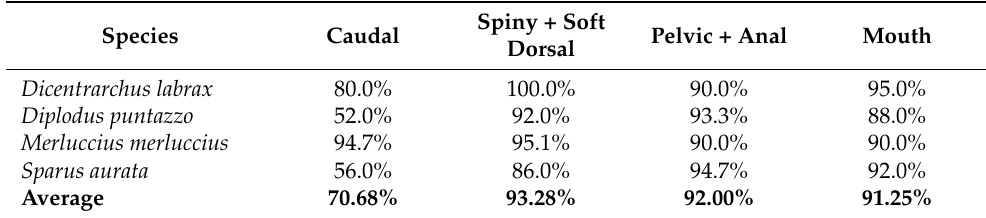
Table 5. Fish part localization for the deep learning BMA approach described in Figure 11. Species